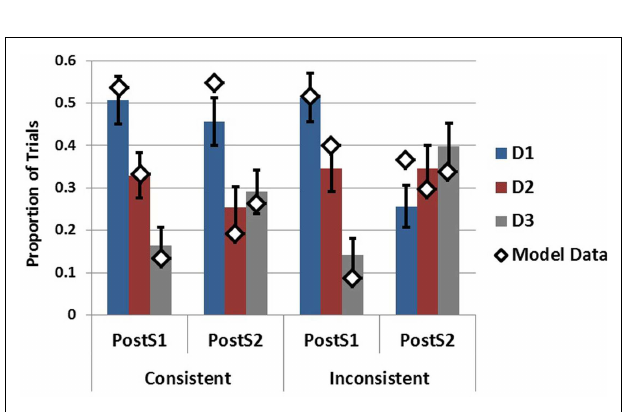
FIGURE 11 | Empirical data (bars) from Experiment 2 in the SbS conditions following S1 and S2 plotted with model data (diamonds). Error bars represent standard errors of the